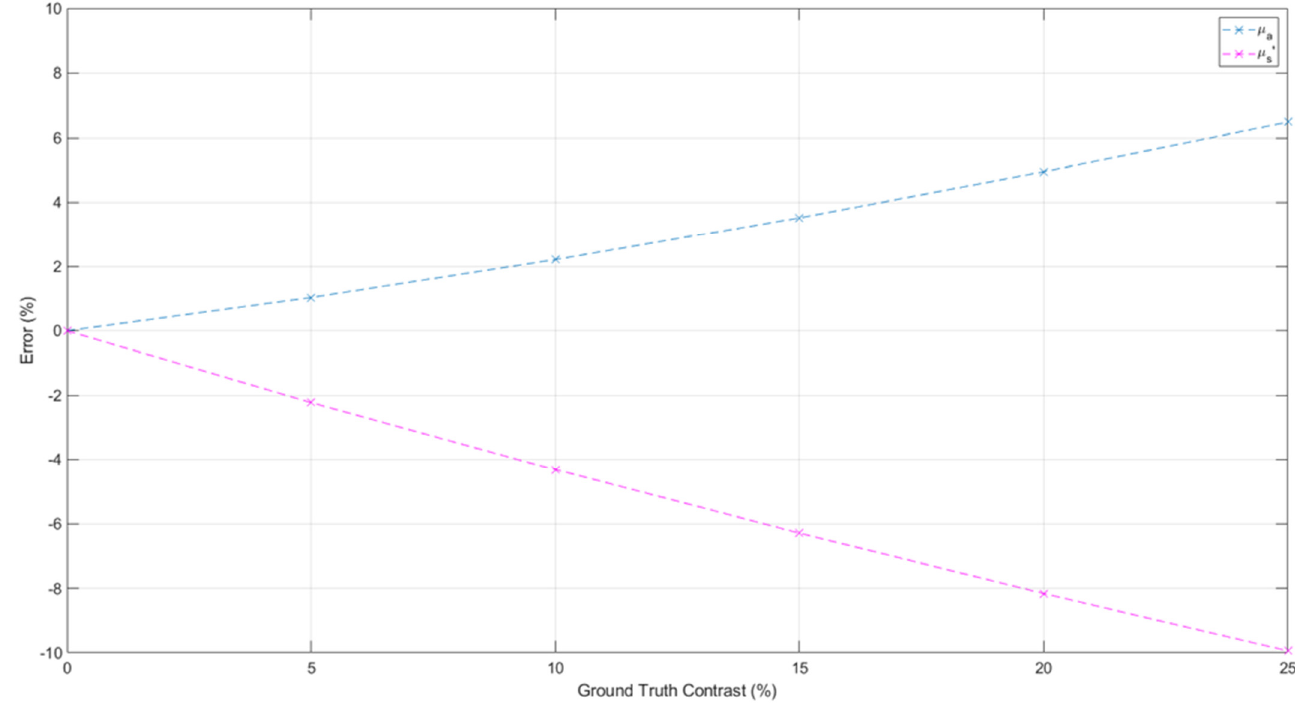
Figure 9. Tri-anomaly model, simultaneous parameter variation. Recovered parameter errors for both absorption and reduced scattering, determined using Equation (8).